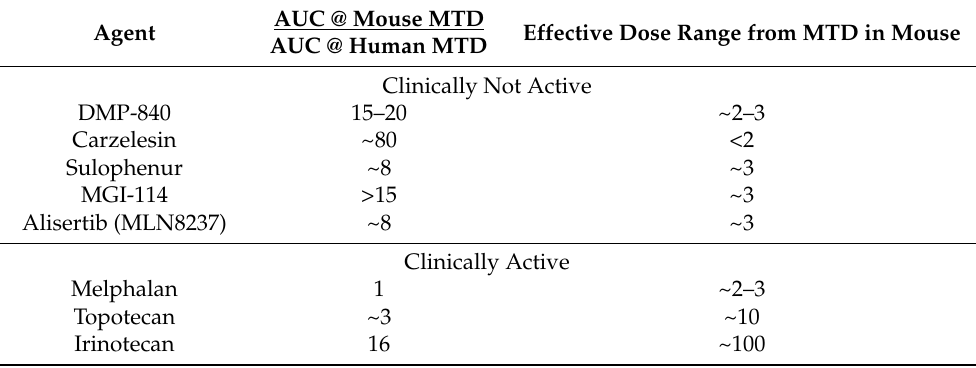
Figure 1. Relative systemic exposures to MGI-114 (acylfulvene) in mice and human. Human and mouse pharmacokinetic data are from Eckhardt et al., 2000 [18], and Leggas et al., 2002 [19], respectively. The AUC (estimated) at the dose of MGI-114 where all 11 PDX models progressed on treatment is shown by the left vertical arrow. Table 1. Relative drug exposures at the mouse and human MTD, and efficacy range in mice.